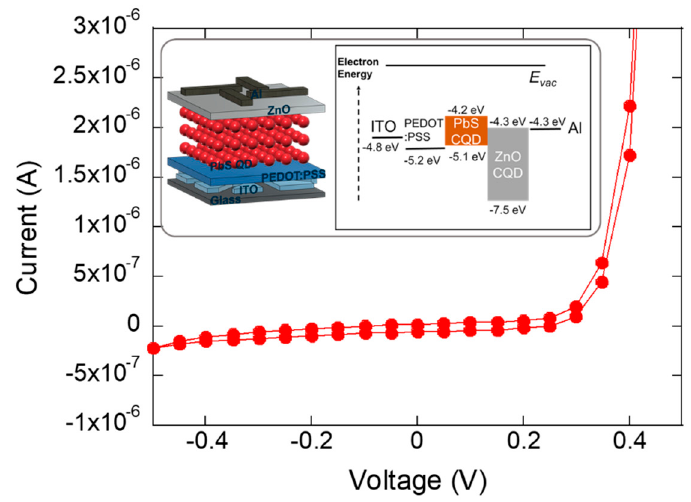
Figure 4. PbS infrared LED I-V characteristic curve.